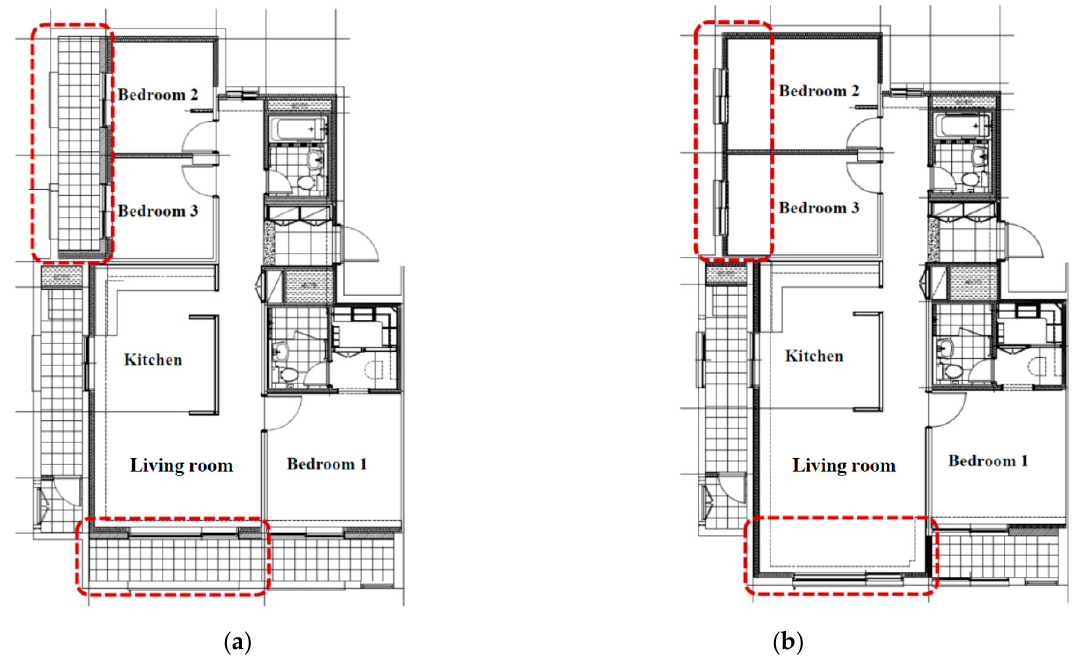
Figure 1. Examples of typical apartment floor plans: ( a ) with a balcony; ( b ) without a balcony.